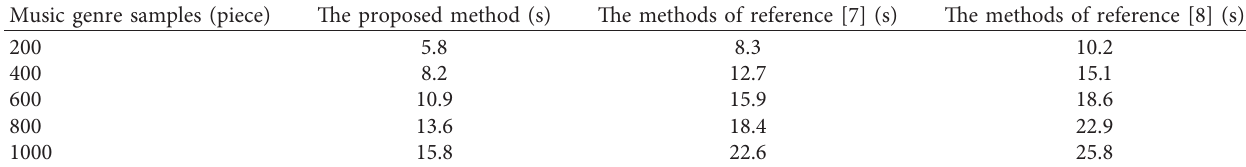
Table 3: Comparison results of different methods of music genre automatic classification